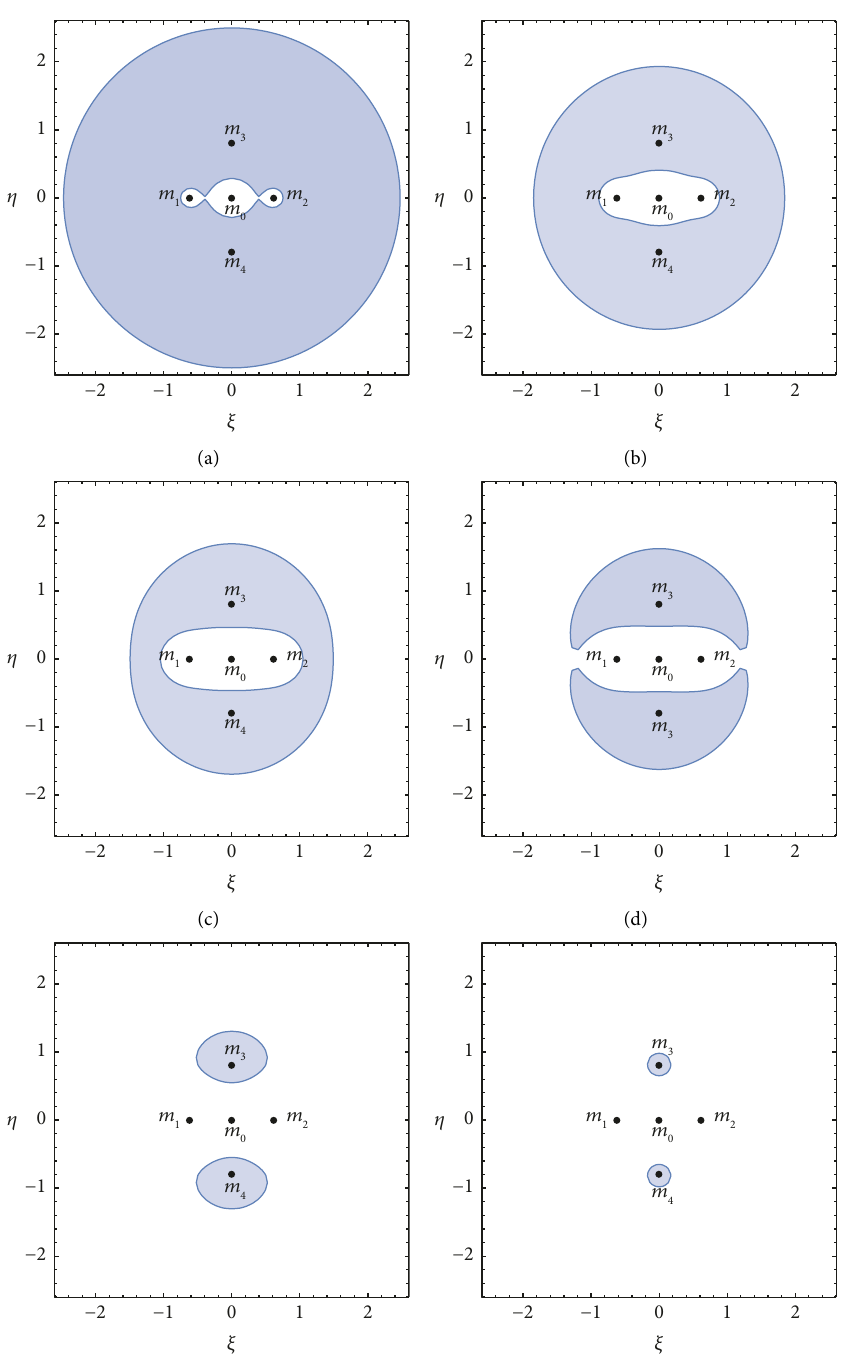
Figure 10: The permitted (white) and prohibited (shaded) regions of motion of m (a) C � − 3 . 49, (b) C � − 2 . 31, (c) C � − 1 . 91, (d) C � − 1 . 80, (e) C � − 1 . 32, and (f) C � − 0 .